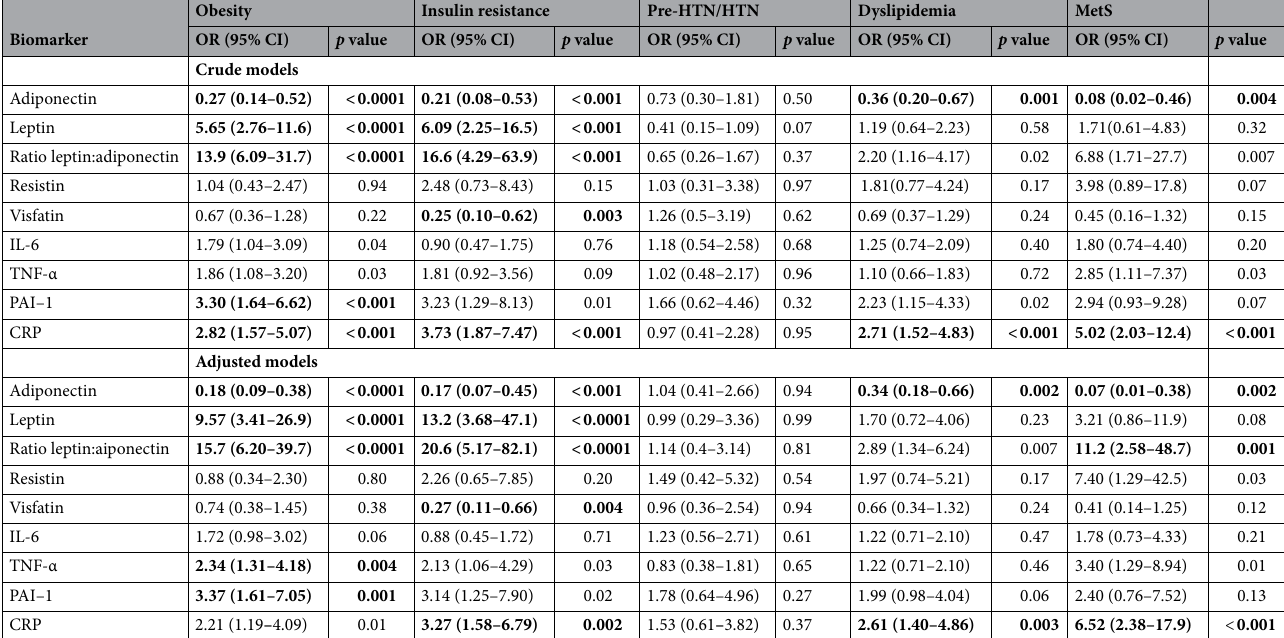
Table 3. Associations between biomarkers of inflammation and cardiometabolic complications in survivors of childhood acute lymphoblastic leukemia: crude and adjusted models. The crude and adjusted models were assessed between each biomarker and each cardiometabolic outcome. Models were adjusted for CRT exposure, age at diagnosis, time since diagnosis and sex. Odds ratio (non-corrected 95% CI) and p-value are indicated for each association. Significant associations are in boldface. Bonferroni-adjusted alpha = 0.05/number of biomarkers = 0.05/9 = 0.006. Metabolic syndrome was defined according to the International Diabetes Federation. CI: confidence interval; CRP: C-reactive protein; CRT: cranial radiotherapy; HTN: arterial hypertension; IL-6: interleukin-6; MetS: metabolic syndrome; PAI-1: plasminogen activator inhibitor-1; TNF- α: tumor necrosis factor-α.